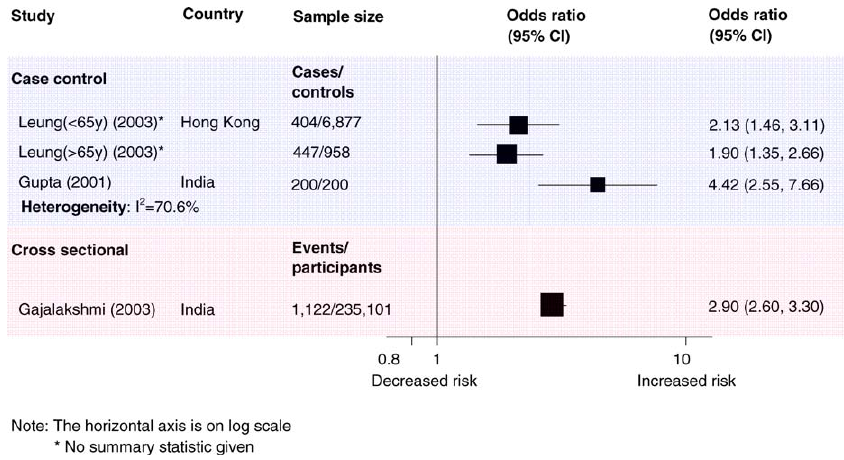
Figure 5. Risk of Clinical TB Disease for Ever Smoking Compared with